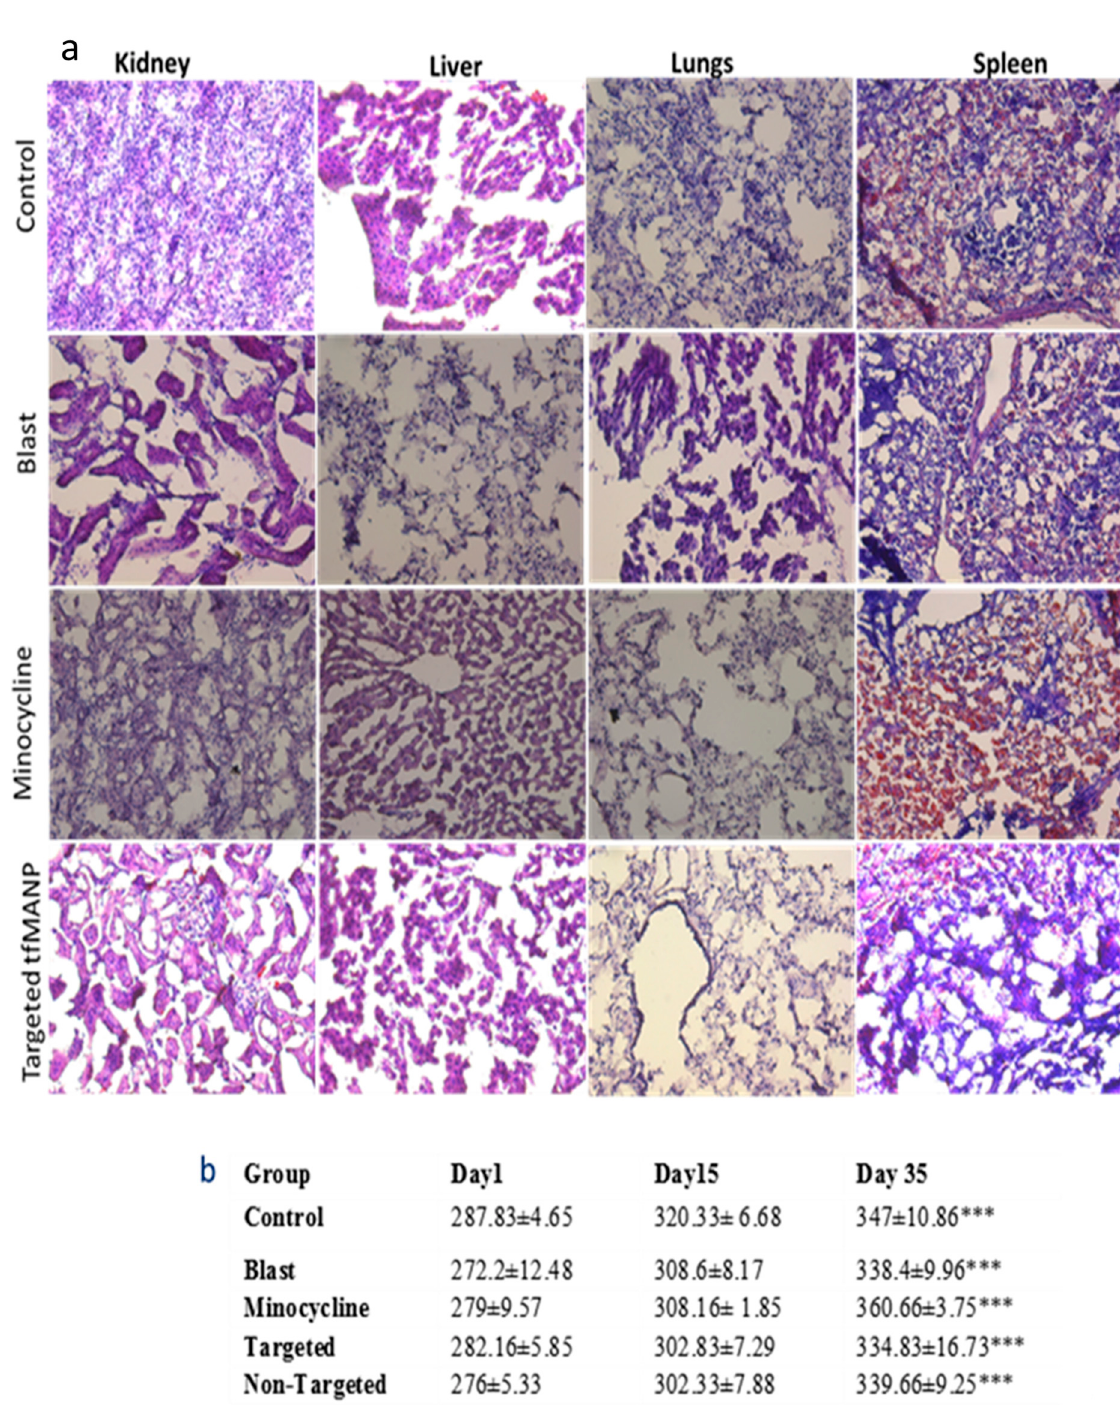
Figure 13. ( a ) Histopathological evaluation of the major organs of rats treated with physiological saline, minocycline, non-targeted MANP (non-targeted) or targeted tfMANP (targeted). Histological analysis of the organs (liver, kidneys, lungs and spleen) compared to the control group. No abnormal histopathological findings were observed in the liver, kidneys, lungs or spleen; ( b ) Body weight changes in blast TBI rats treated with physiological saline, blast, minocycline, non-targeted MANP (non-targeted) or targeted tfMANP (targeted). *** p < 0.001. Body weight examinations: Neither the free drug nor the nanoformulation should induce overt toxicity nor greater than 10% retardation of body weight as compared